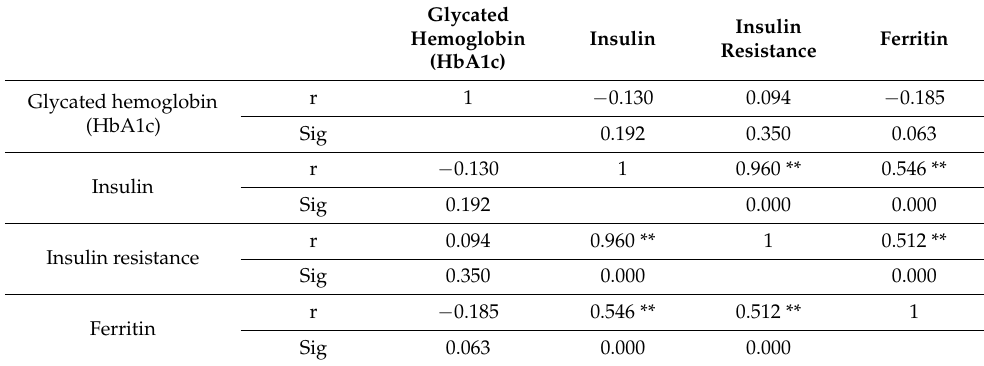
Table 4. Pearson’s correlation of insulin resistance with other